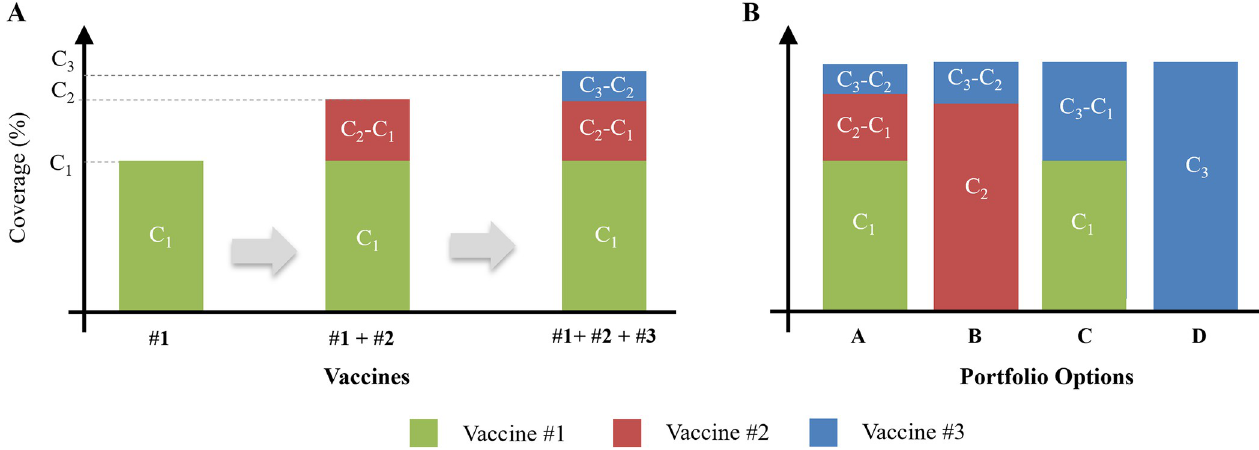
Fig 3. Conceptual diagram showing how the authors’ previously published coverage model can be used to estimate the relative proportion of each presentation in a portfolio. Panel A shows how adding vaccines sequentially results in a marginal increase in coverage. Panel B shows how changing the order in which vaccines are added results in different portfolio